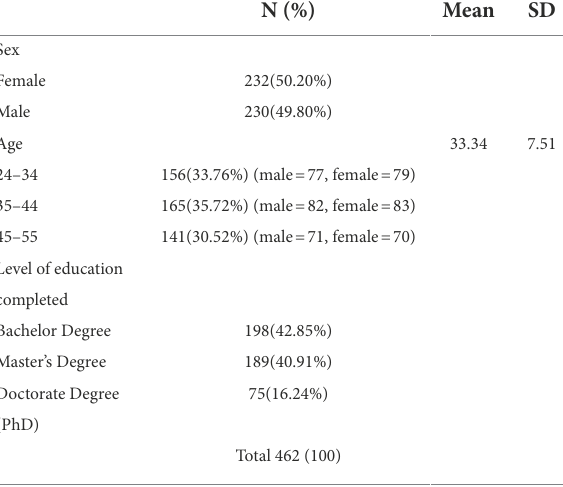
TABLE 1 Description of participants’ demographic